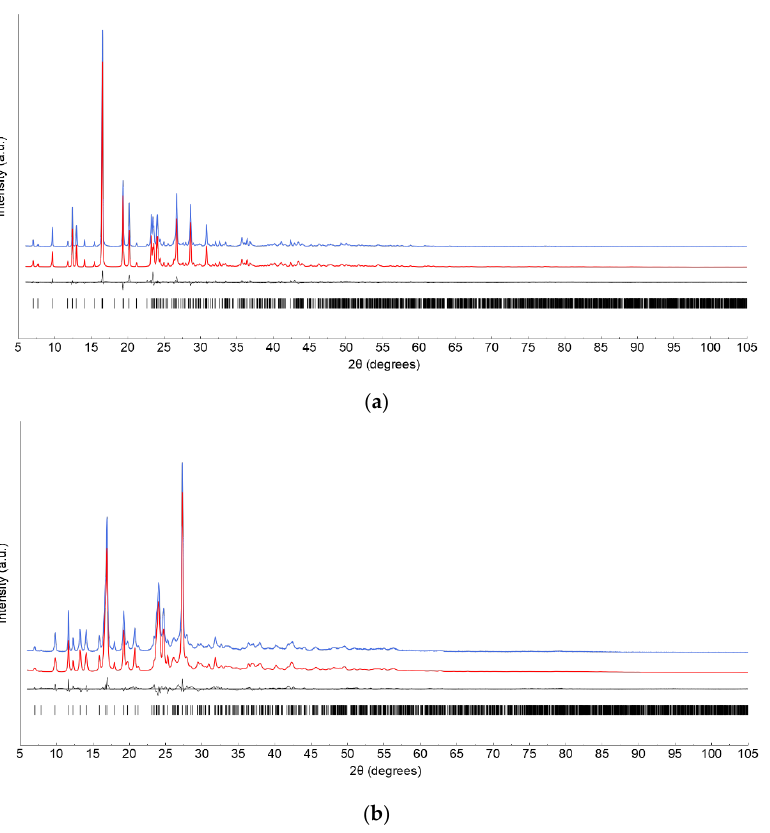
Figure 2. Rietveld refinement plots for Tafamidis Form 1 ( a ) and Tafamidis Form 4 ( b ), with peak markers and difference plot at the bottom. Observed data in blue and calculated trace in red, offset on the y axis for clarity. Table 1. Crystal data and data analysis parameters for Tafamidis Form 1 and Form 4 .